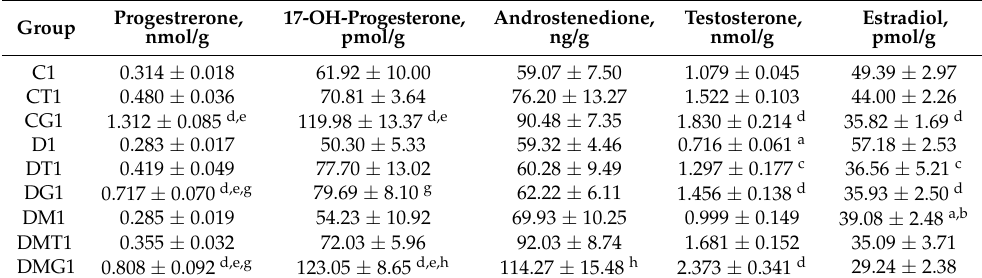
Table 4. The influence of a single dose of hCG and TP3 on the testicular levels of testosterone, estradiol and their precursors in the control and diabetic rats, and the effect of five-week metformin treatment. Group Progestrerone, nmol/g 17-OH-Progesterone, pmol/g